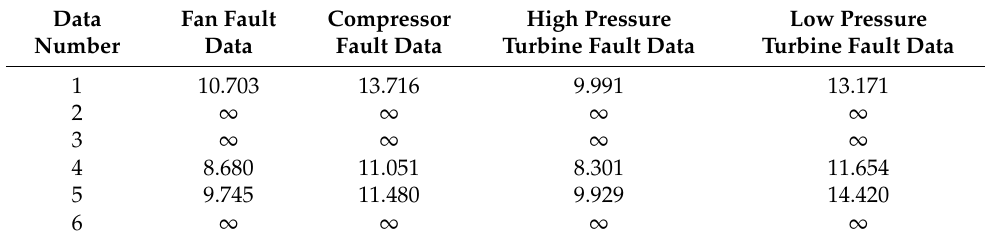
Table 8. Distances of residual components.